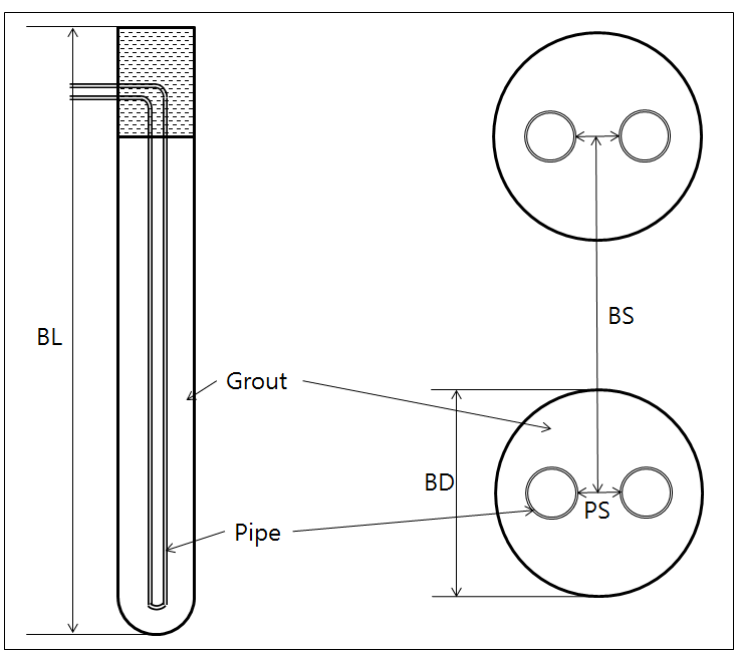
Figure 2. Components of Ground Source Heat Pump (GSHP)